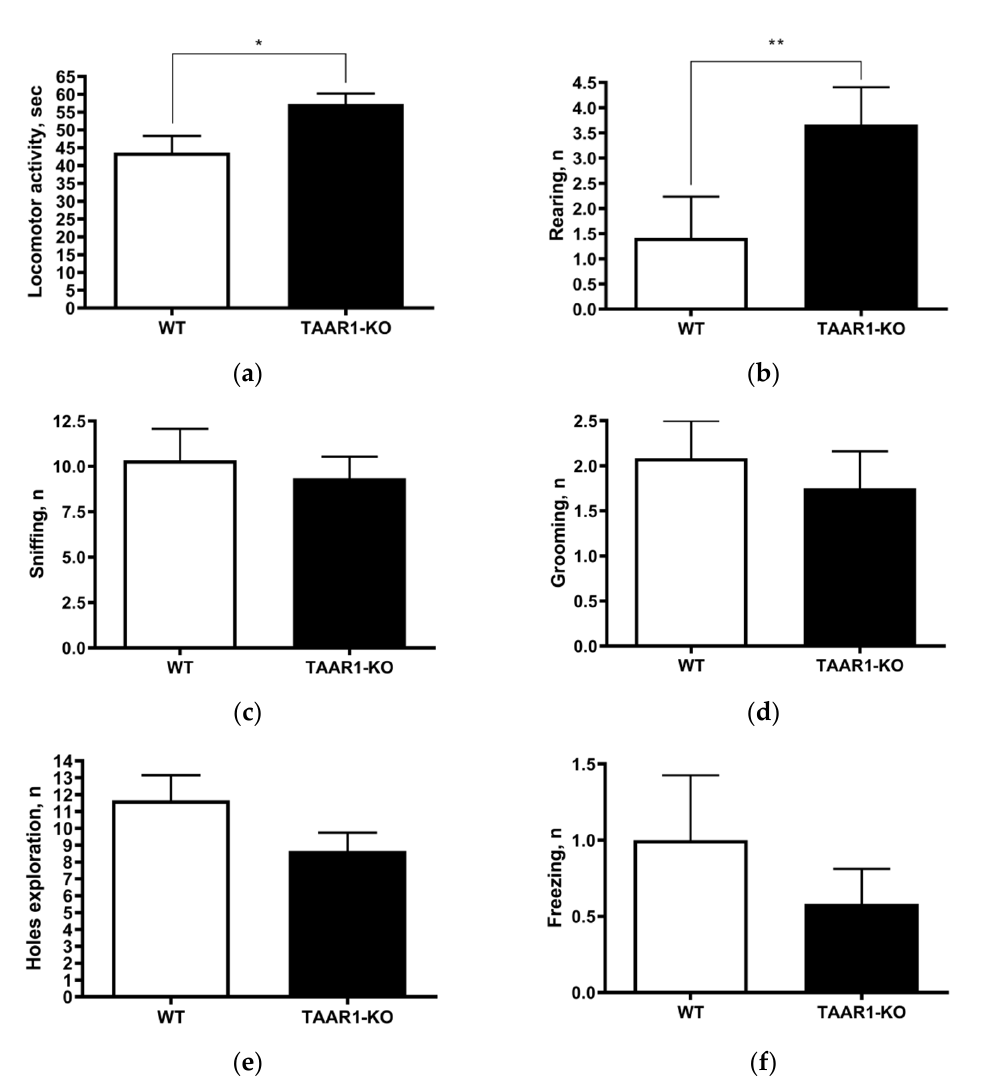
Figure 1. Circular open-field testing data show increased locomotor activity (( a ); wild type (WT) = 43.67 ± 4.62, vs. TAAR1 knockout (KO) = 57.33 ± 2.93, p = 0.0271) and more vertical rearing (( b ); WT = 1.42 ± 0.82, vs. TAAR1-KO = 3.67 ± 0.74, p = 0.0061), but unaltered sniffing, self-grooming, freezing and hole exploration ( c – f ) in TAAR1-KO vs. WT control mice. Data are presented as mean ± SEM (n = 12). * p < 0.05, ** p < 0.01 vs. control, Mann–Whitney U-test.